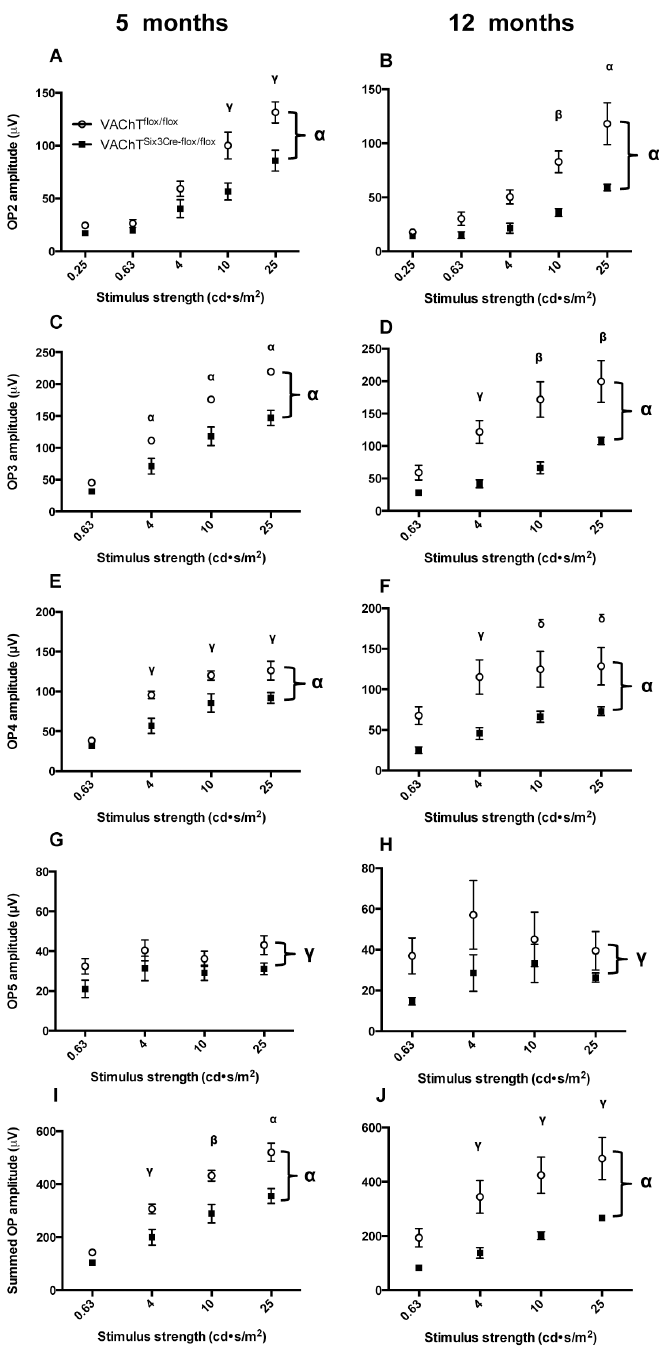
Fig 8. Assessment of oscillatory potential (OP) amplitude profiles. (A-H) Quantification of individual OP amplitudes for the second to fifth OPs (2 – 5), respectively, also shows a significant reduction in VAChT Six3-Cre-flox/flox mice compared to VAChT flox/flox littermate controls. Quantification of summed OP amplitude for the four OPs measured over the four largest stimulus strengths (0.63 – 25 cd+s /m 2 ) under scotopic conditions measured shows a significant decrease in VAChT Six3-Cre-flox/flox retinas (open circles) relative to littermate controls (VAChT flox/flox , closed squares) at (I) 5 (n = 7 VAChT Six3-Cre-flox/flox and n = 12 littermate control) and (J) 12 months of age (n = 5 VAChT Six3-Cre-flox/flox and n = 5 littermate control). Values represent the mean ± SEM. δ , P < 0.05; γ , P < 0.01, β , P < 0.001, α , P < 0.0001 versus control